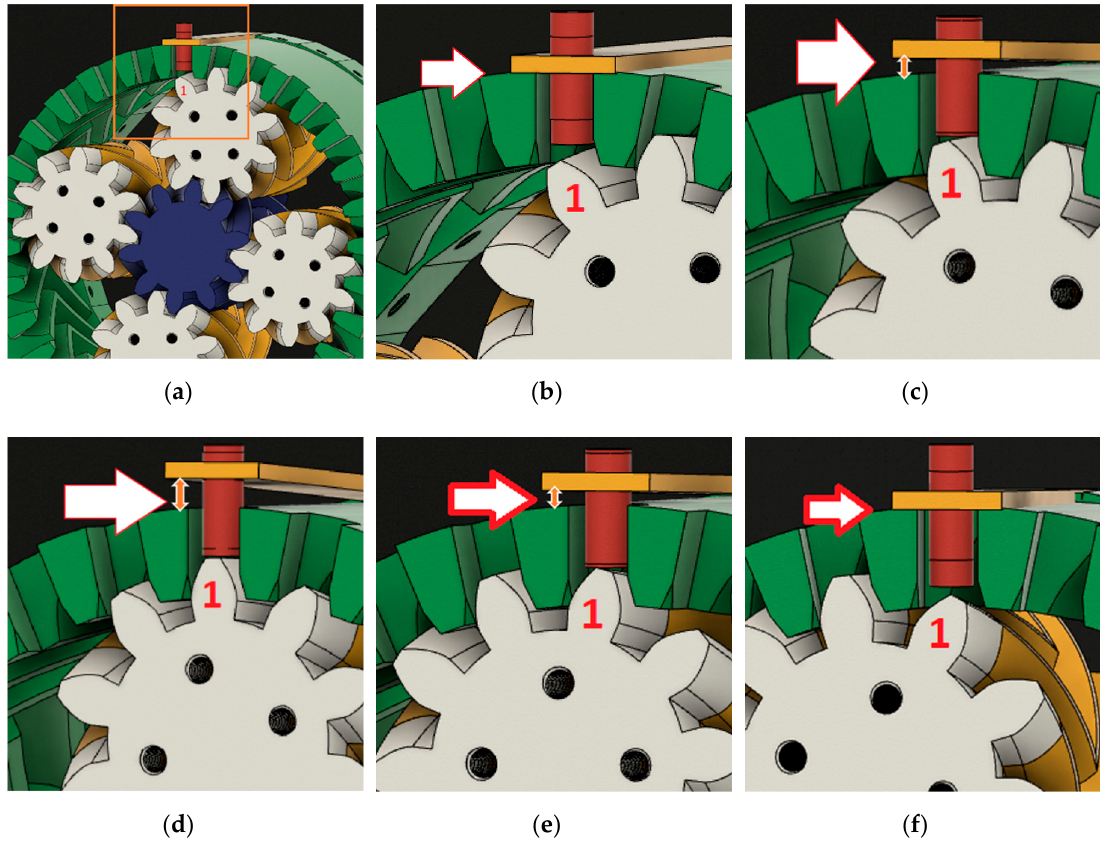
Figure 4. Sequence of PZT bending for one of planet cover teeth named No. 1 and the arrow shows how much the PZT bends at each stage: ( a ) the whole prototype, ( b ) before, (no bending), ( c ) 50% bending, ( d ) 100% bending, ( e ) 50% bending and ( f ) after (no bending).